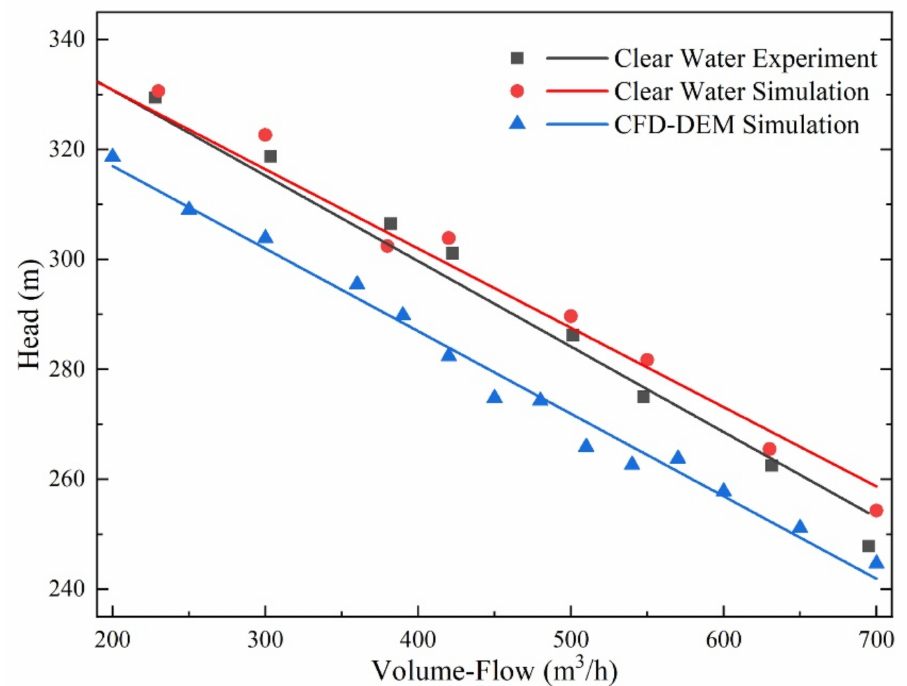
Figure 10. Total head comparisons of simulation and an experiment of the six-stage centrifugal pump at 1450